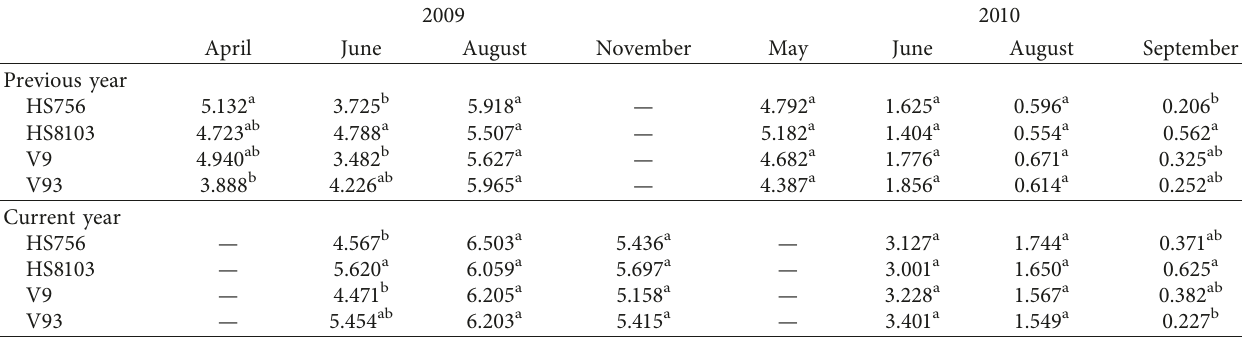
Table 2: Light-saturated photosynthesis ( A · m − 2 · s − 1 ) of previous- and current-year foliage of loblolly pine genotypes at a site in sat ; µ mol North Central Louisiana in 2009 (temperate year) and 2010 (droughty year).